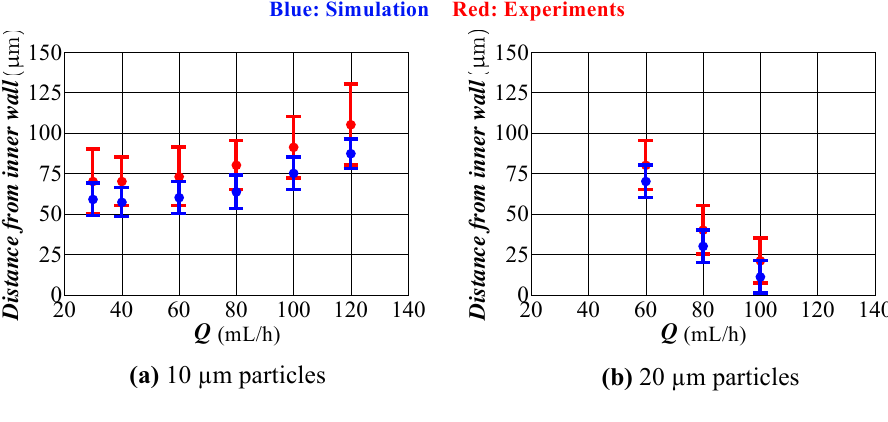
Figure 11. Comparison of the simulations with the experimental results (AR = 9.0). ( a ) 10 µ m particles; ( b ) 20 µ m